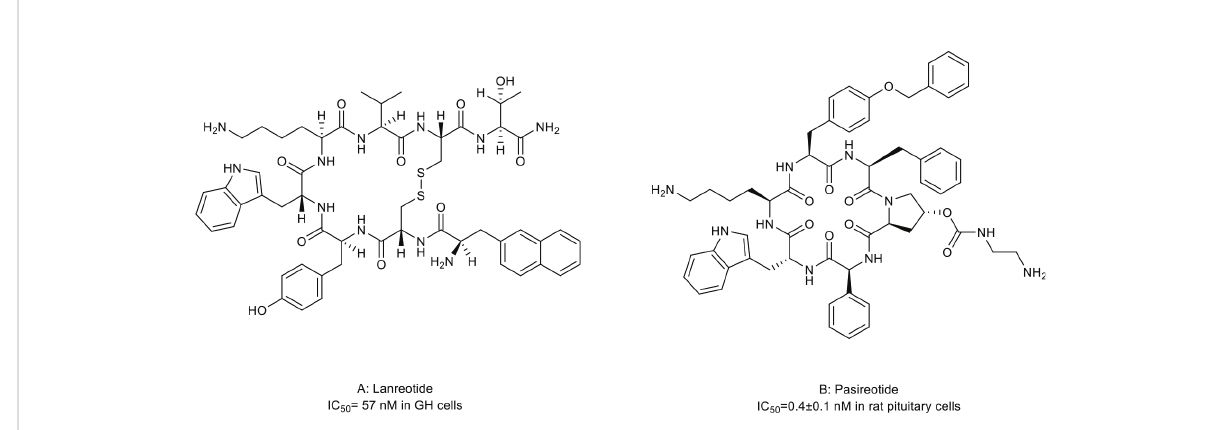
FIGURE 2 Macrocyclic peptides targeting somatostatin receptors. (A) Lanrenotide. IC50: 57 nM in GH cells; (B) Pasireotide, IC50: 0.4±0.1 nM in rat pituitary